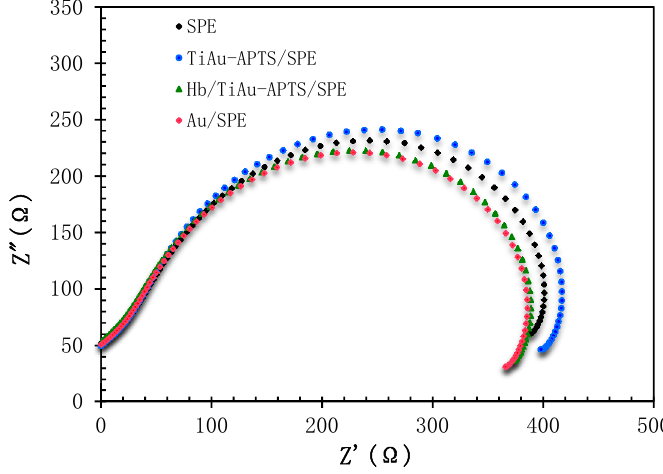
Figure 4. The Nyquist plot of different modified SPEs in PBS (0.1 M NaCl, pH 7.4).